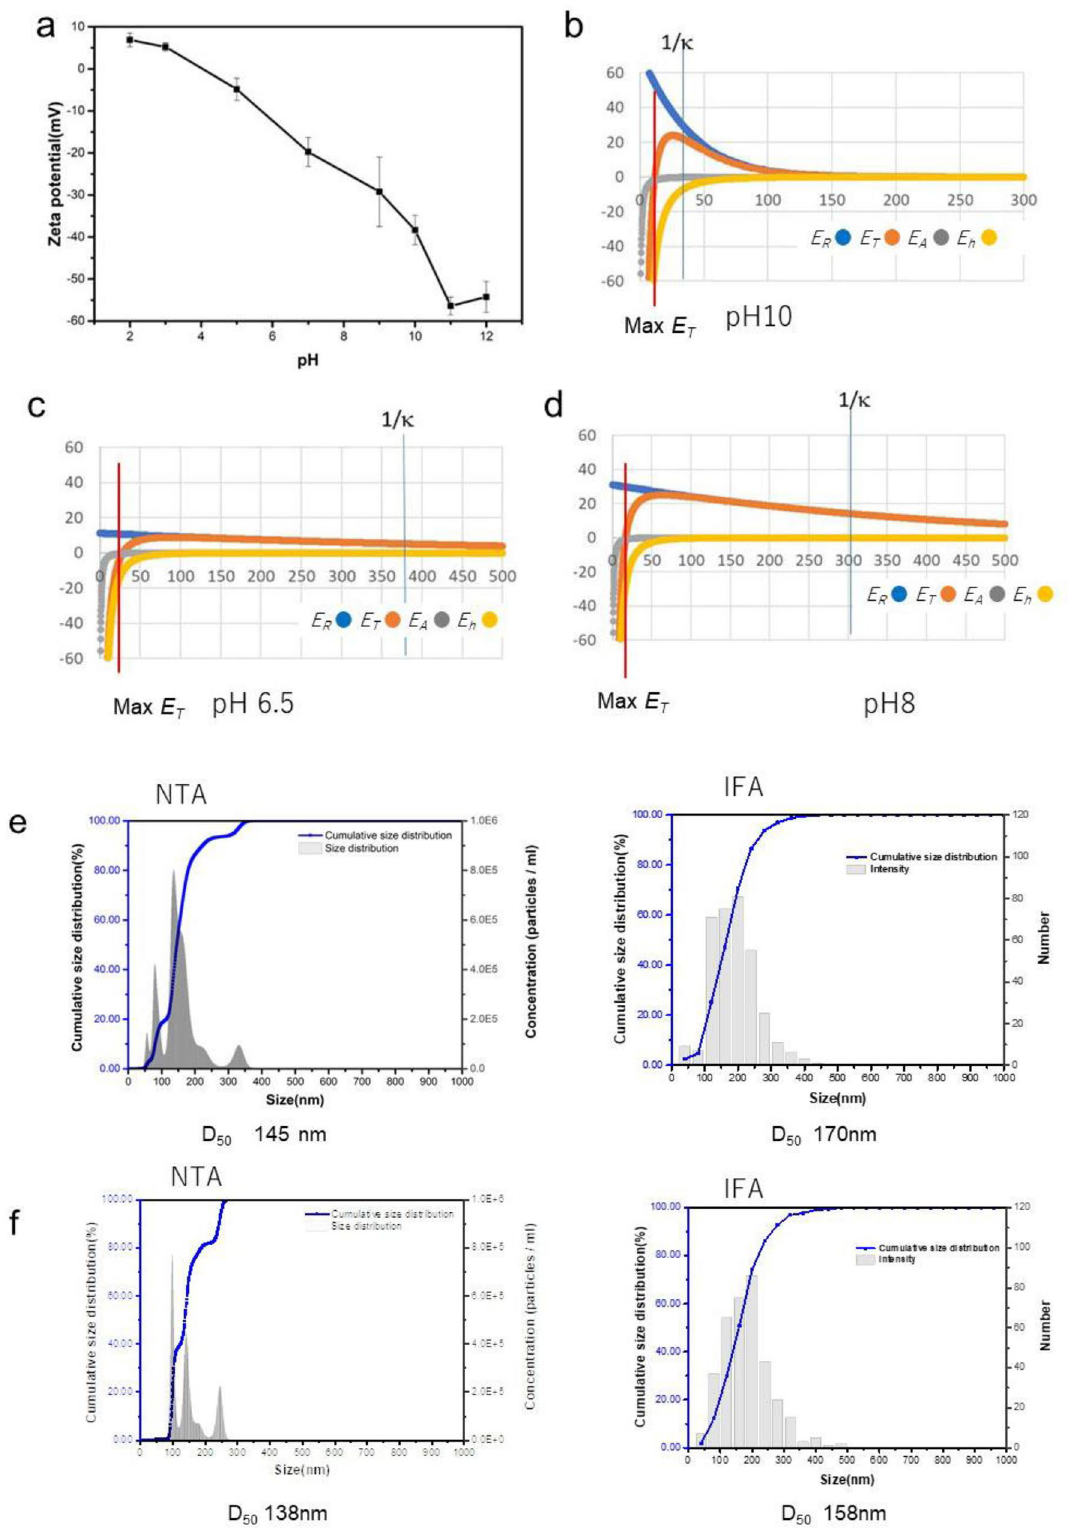
Figure 4. Nanobubble stability by two-particle interactions. ( a ) Zeta potential of air nanobubbles in water depending on pH. Air nanobubbles were produced by blowing air through porous media in deionized water. The total potential energy of nanobubbles ET, van der Waals energy EA, hydrophobic interaction energy Eh, and electrostatic interaction energy ER depending on pH are shown in b to d. The calculation method (refer to Supplementary Note 9). ( b ) Potential energies between two nanobubbles as a function of their separation distance at pH 10. ( c ) Potential energies between two nanobubbles as a function of their separation distance at pH 6.5. ( d ) Potential energies between two nanobubbles as a function of their separation distance at pH 8. ( e ) NTA and IFA nanobubble size distribution at pH 6.5 produced by porous media (tube). ( f ) NTA and IFA nanobubble size distribution at pH 8.0 produced by porous media